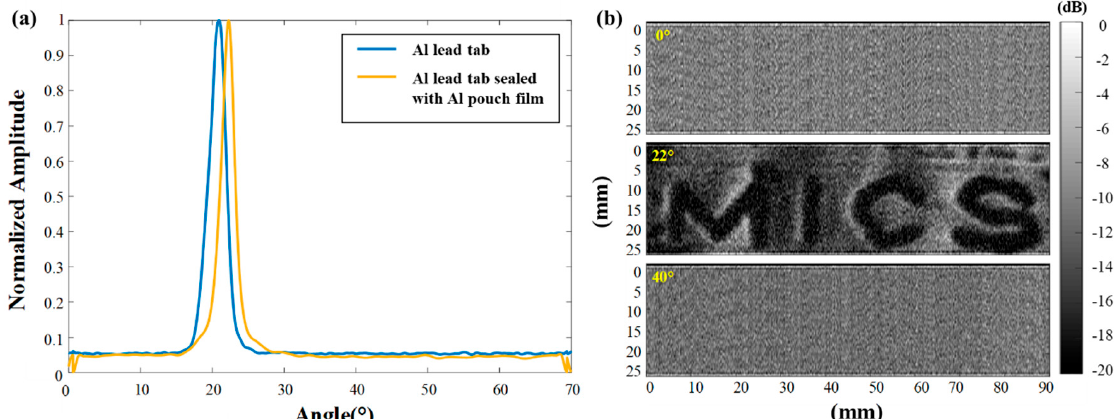
Figure 3. ( a ) Angle experiment results of the single Al lead tab and the Al lead tab sealed with the Al pouch film. All the test pieces have peak values of 20~23°. ( b ) A 2D scan result of the inhouse Li-ion pouch battery defect model with foreign defect material. The incident angle θ was successively set to 0°, 22°, and 40°.